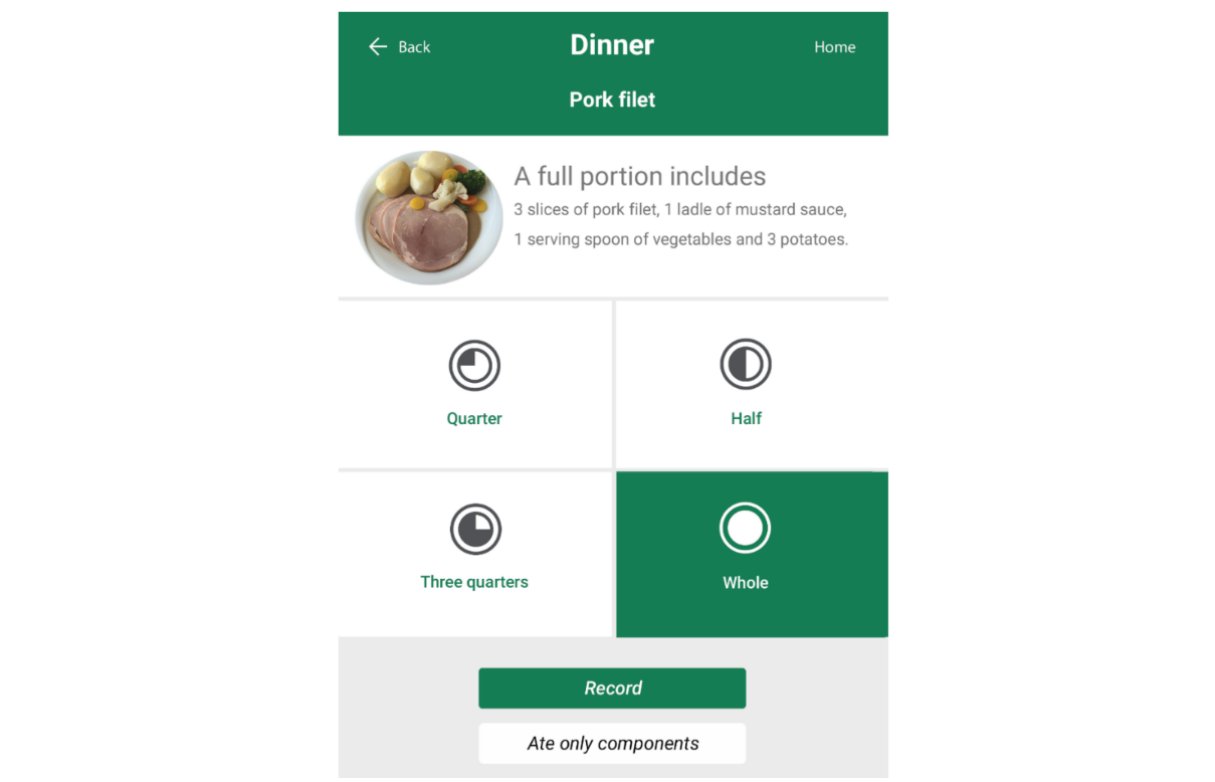
Figure 3. Recording of hot dishes in